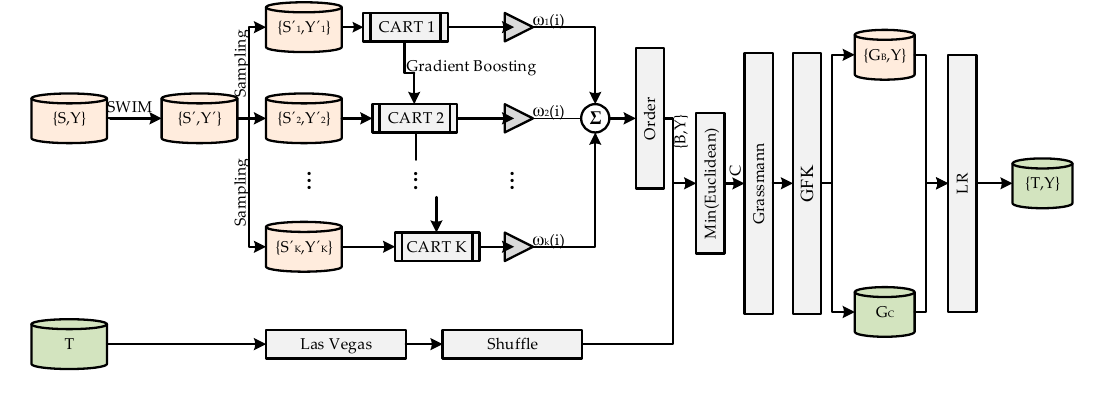
Figure 1. The overall architecture of GMOTDP.